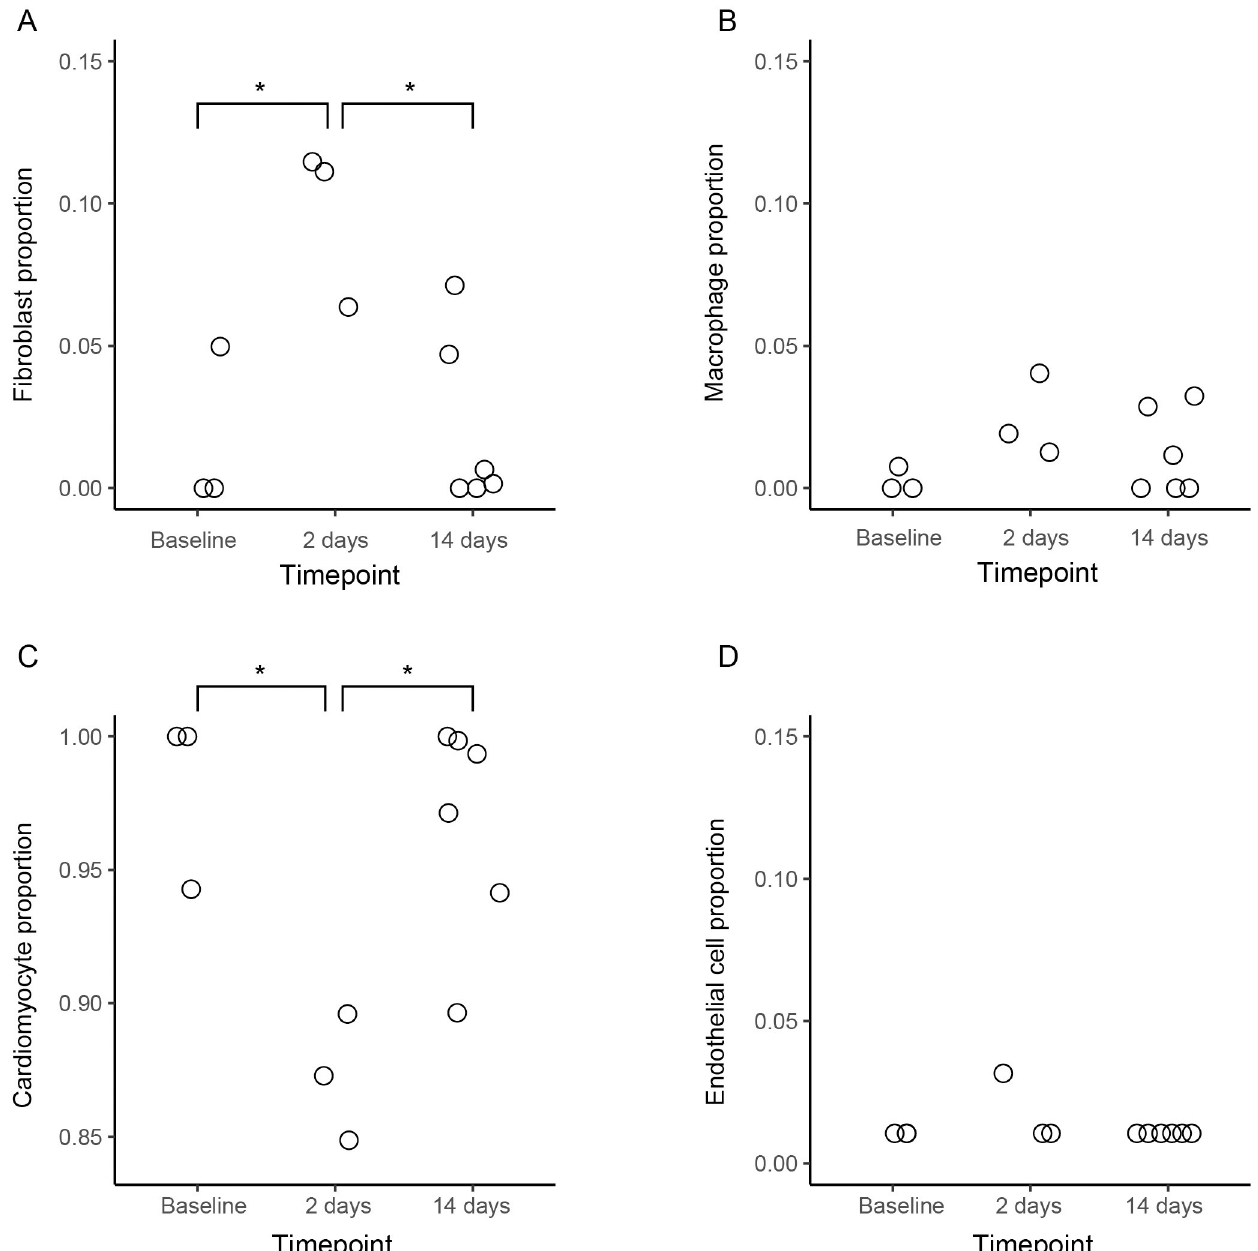
Fig 4. Estimated proportions of cell types in myocardial samples (n = 12). (A) Estimated proportion of fibroblasts. Significant difference between baseline and day two samples (unpaired t-test, adjusted p value < 0.02), as well as between day two and day 14 samples (adjusted p value < 0.02). (B). Estimated macrophage proportion. No significant differences between groups (adjusted p values > 0.05). (C) Estimated proportion of cardiomyocytes. Significant difference between baseline and day two samples (adjusted p value < 0.01), as well as between day two and day 14 samples (adjusted p value < 0.01). (D) Estimated endothelial cell proportion. No significant differences between groups (adjusted p values >